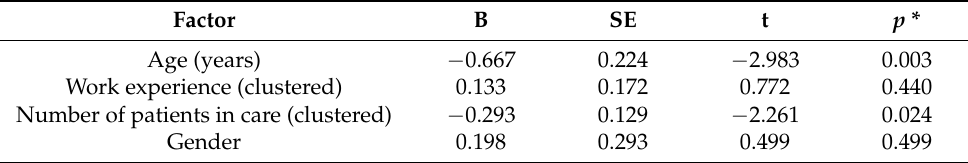
Table 5. Factors influencing knowledge about asymptomatic hyperuricemia and gout. Factor Work experience (clustered) Number of patients in care